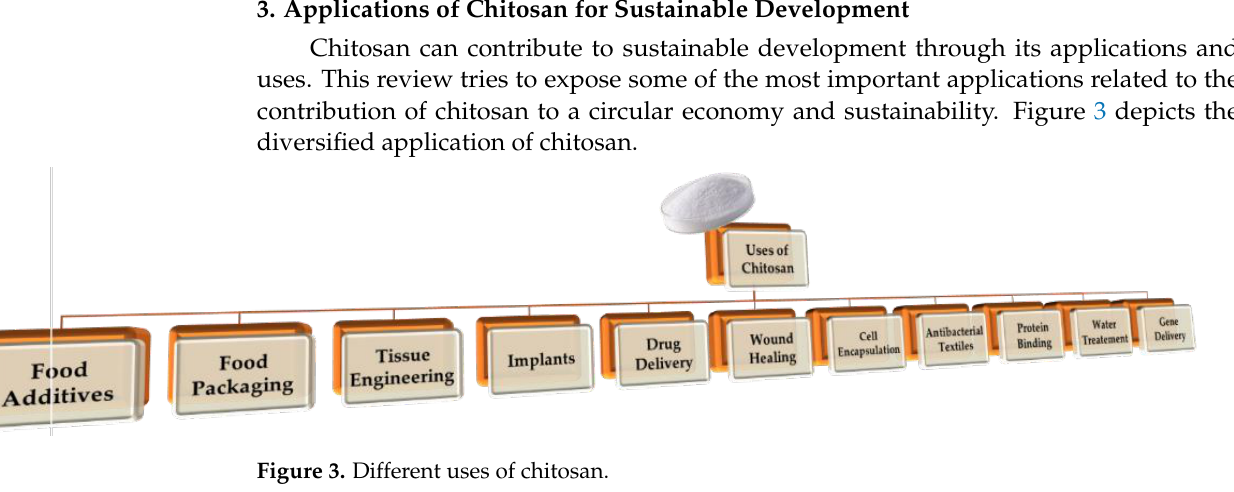
Figure 3. Different uses of